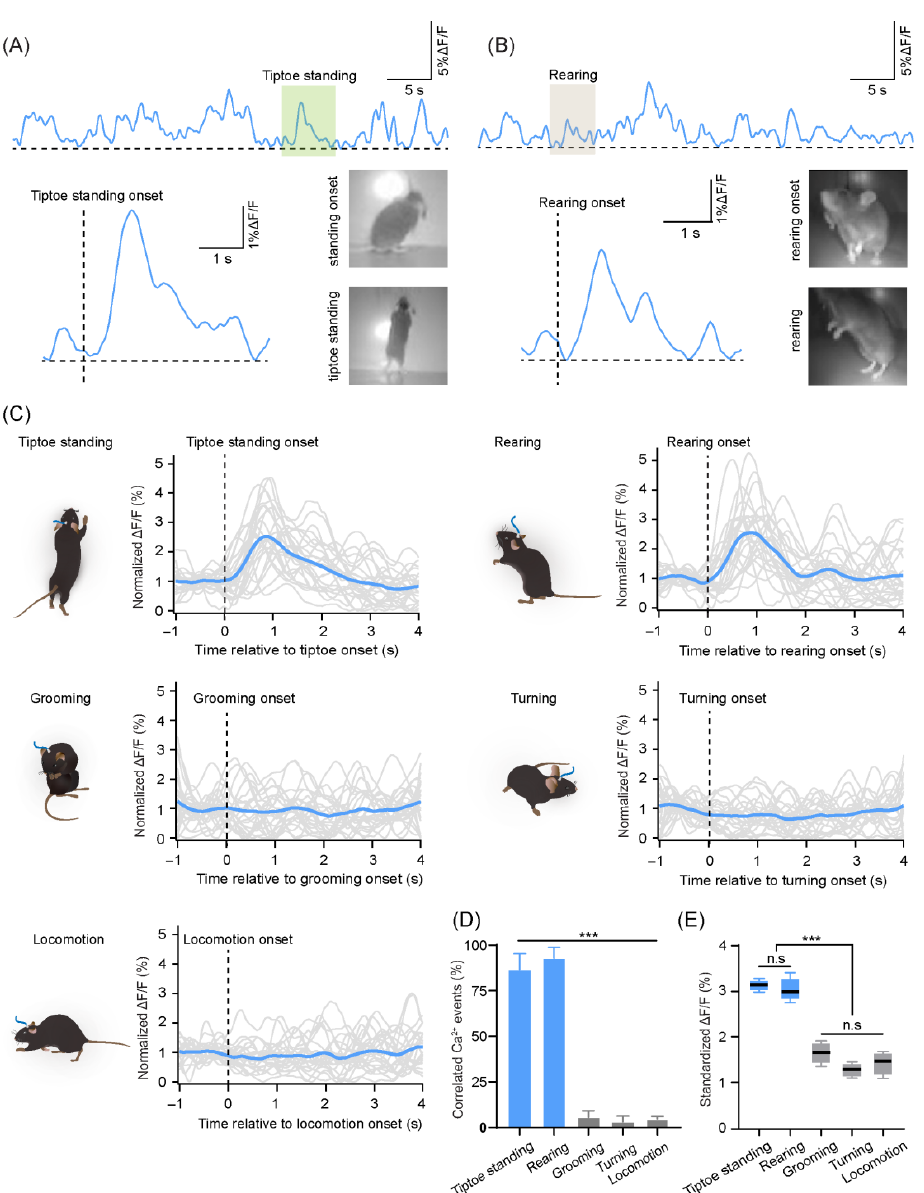
Figure 5. Correlation between various behaviors and the corresponding climbing fiber (CF) Ca 2+ signals. ( A ) Example behavioral onset and the Ca 2+ signal of event “tiptoe standing”. ( B ) Example behavioral onset and the Ca 2+ signal of event “rearing”. ( C ) Five types of behaviors were summarized from 60 min videos recorded in the open field (25 events from four mice for each behavior). Ca 2+ signals for each event (grey lines) are aligned to behavior onset and the average fluorescence changes (ΔF/F) across all events are shown (blue line). ( D ) The correlation of Ca 2+ transients with each behavioral motif as defined in panel ( C ). The correlated Ca 2+ events were detected in a time window of 500 ms after the onset of behavior. There were 53 of 61 events of tiptoe standing (86.7 ±